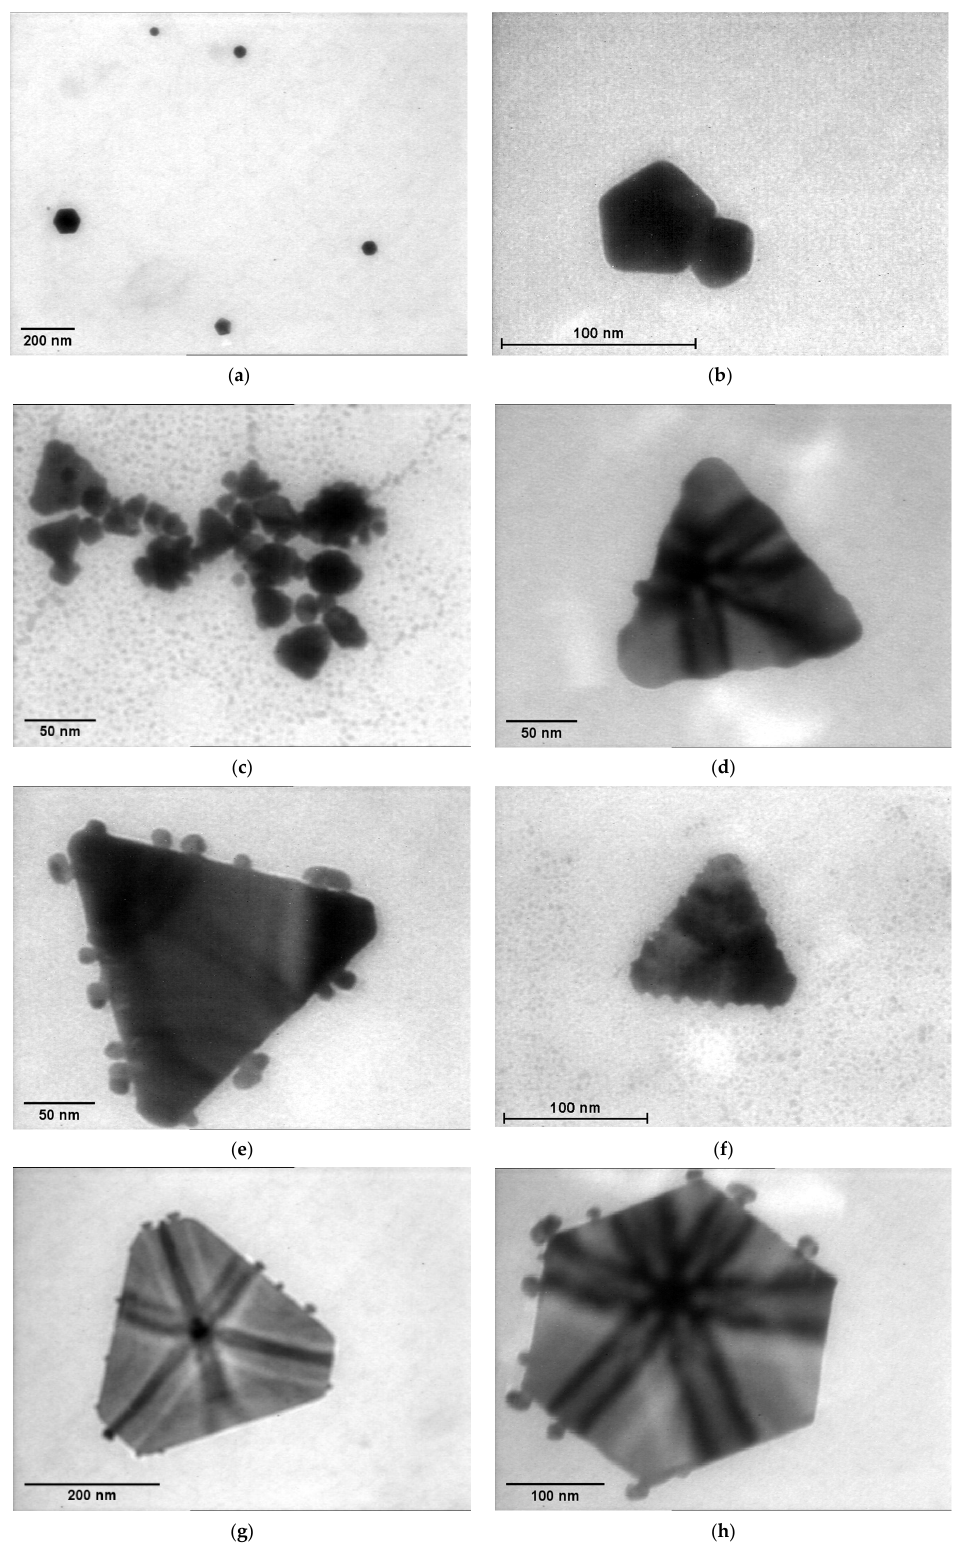
Figure 6. Examples of TEM images capturing the Ostwald ripening process for: ( a ) P 0.18; ( b ) P 0.24; ( c ) M 0.18; ( d ) M 0.24; ( e ) M 0.30; ( f ) L 0.18; ( g ) L 0.24; ( h ) L 0.30.